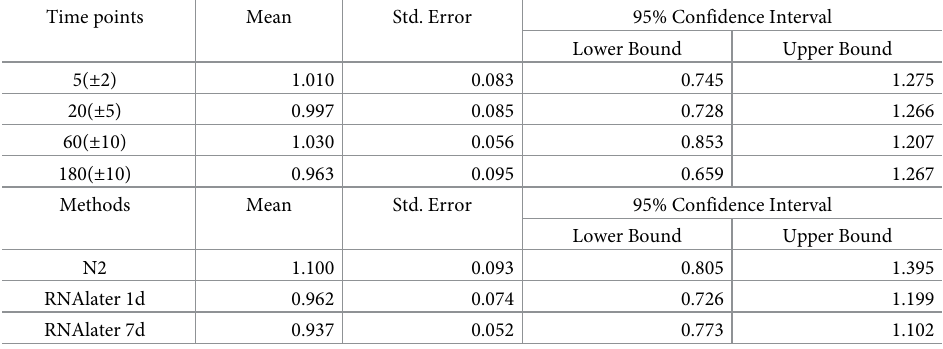
Table 3. Variation for average gene